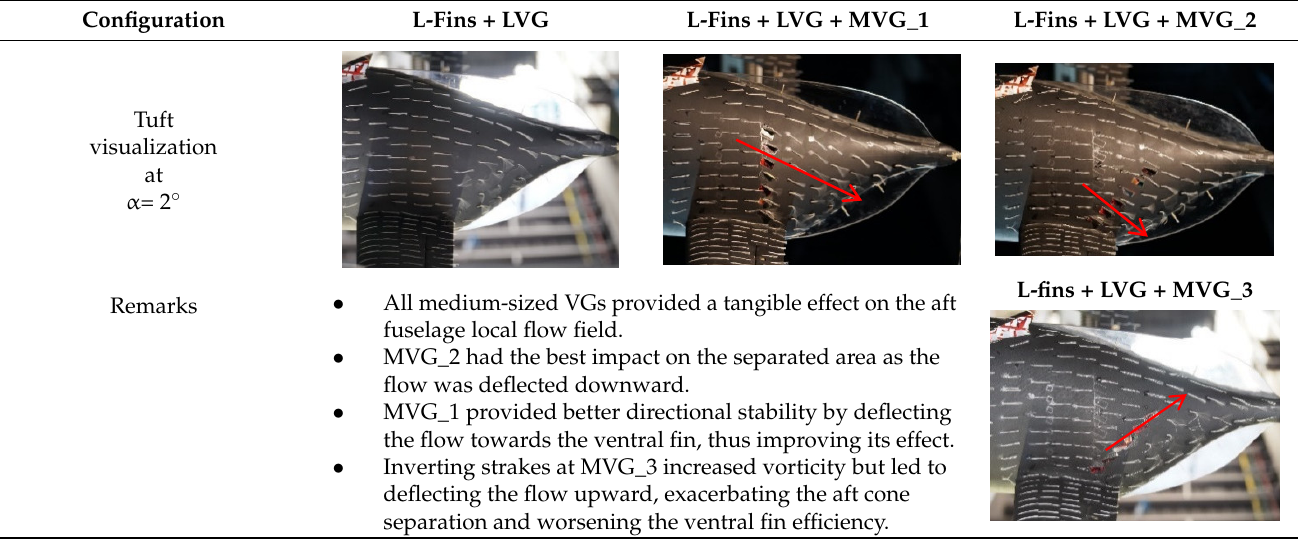
Figure 19. Drag coefficient (Cd) of the model equipped with combinations of L-fins, LVG, and MVG_1. Table 5. Aft fuselage tuft flow visualization with medium VG installed in configurations 1, 2, and 3.